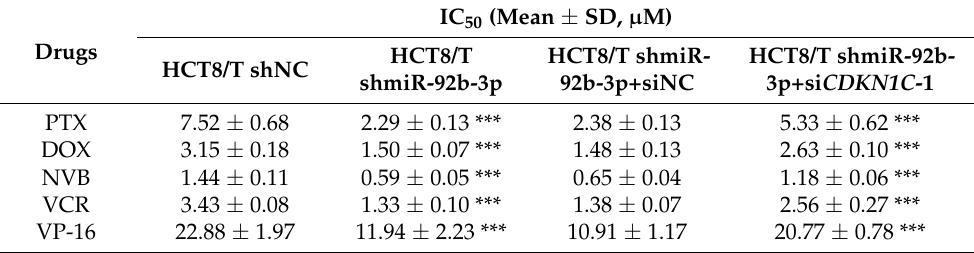
Table 4. Silencing of CDKN1C reverses the effect of miR-92b-3p knockdown on drug resistance of HCT8/T cells to chemotherapeutic drugs. Cell survival curves of multiple chemotherapeutic agents were measured by CCK8 assay after 72 h treatment with agents (in gradient concentrations) and the IC 50 values were calculated based on a non-linear regression analysis. All experiments above were repeated three or more times independently and values are shown as mean ± SD. versus control cells, respectively. *** p <